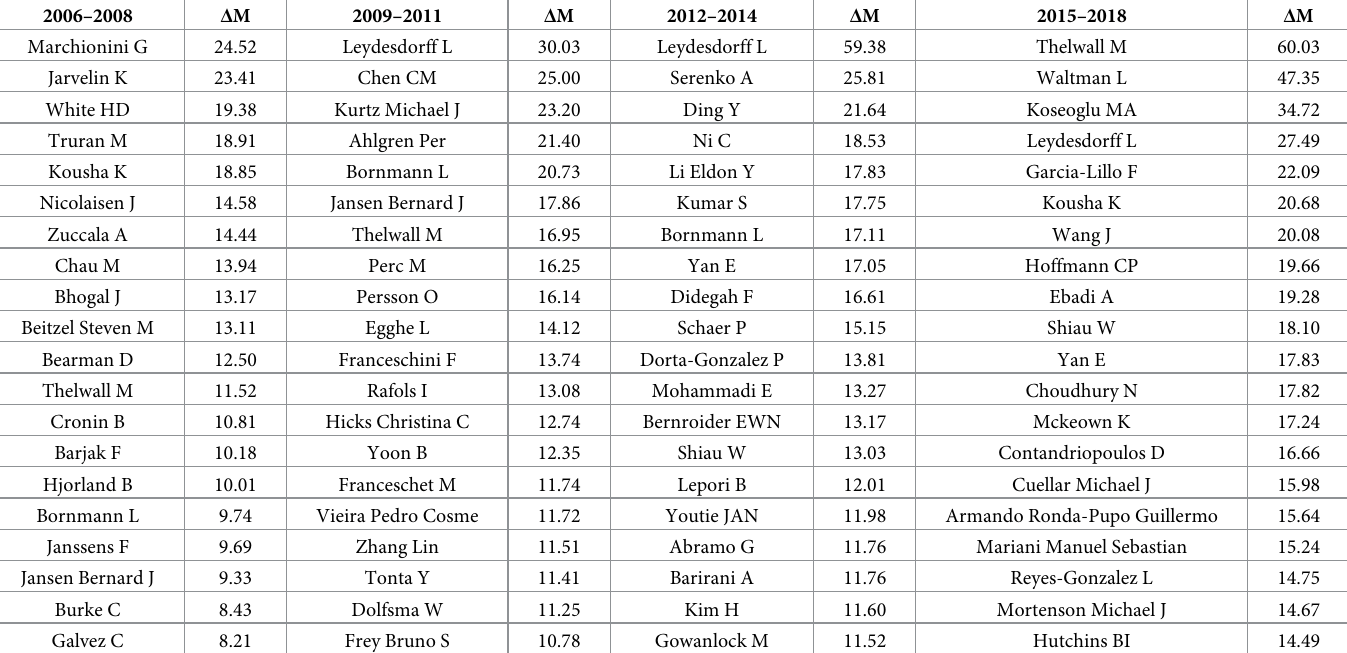
Table 8. Top 20 researchers with the largest Δ M in each of the 3-year time interval (2006–2018).